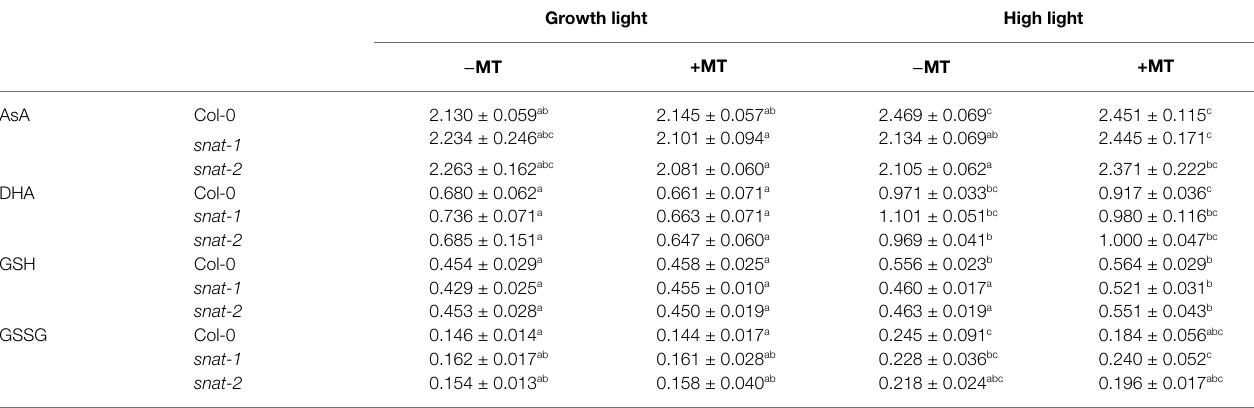
TABLE 1 | Effects of exogenous melatonin on non-enzymatic